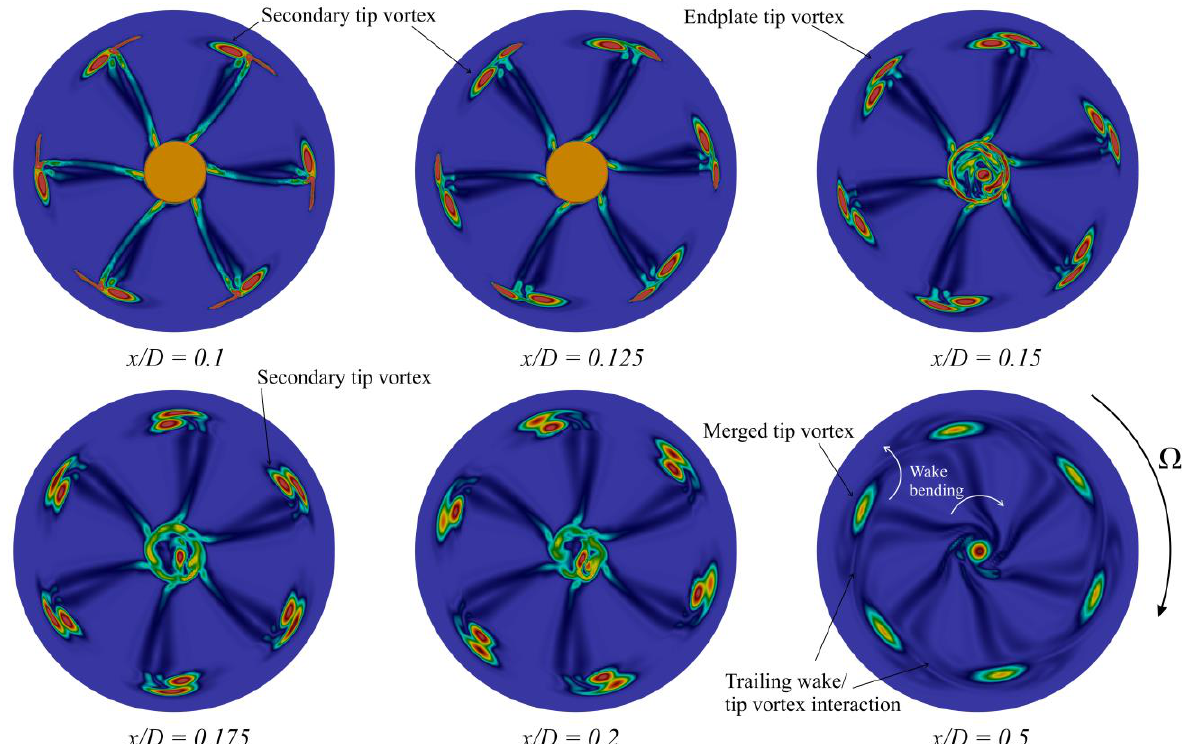
Figure 19. Transverse distributions of vorticity (magnitude) at different axial locations down- stream the propeller. New generation CLT propeller at the loaded condition ( J = 0.6).